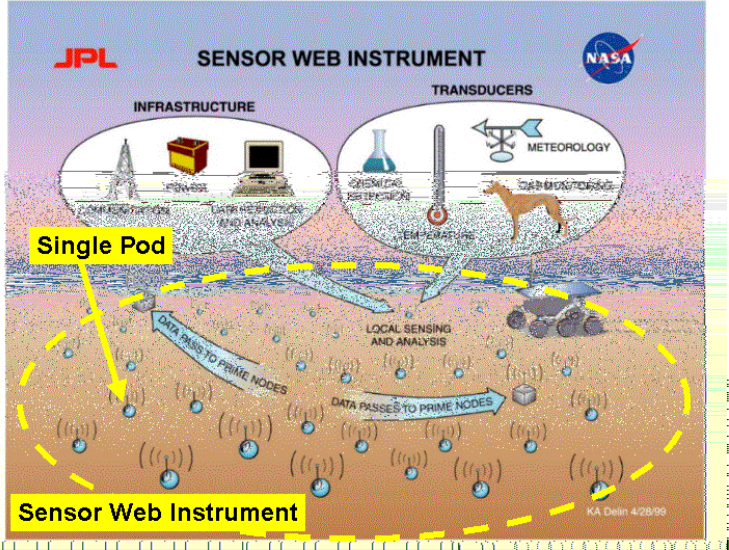
Figure 3. Sensor Web concept as applied to an in situ terrestrial environment. The Sojourner rover of the Mars Pathfinder mission is provided for scale.